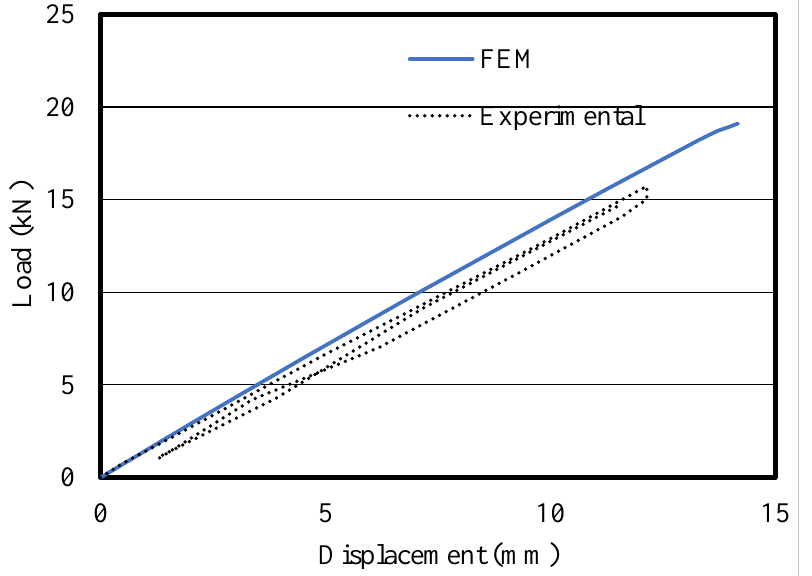
Figure 11. Comparison of bending load–displacement relationship between FEM and experimental test of GFRP pultruded beam [27].